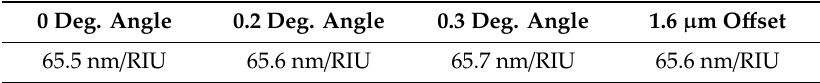
Figure 6. Simulation of the CL interferometer with di ff erent cleave angles shows reduced visibility of the interference. In the range 1400–1500 nm, the decrease is 20–70% for 0.3 degrees cleave angle. Table 2. Refractive index sensitivity for di ff erent inaccuracies, calculated at 1550 nm.